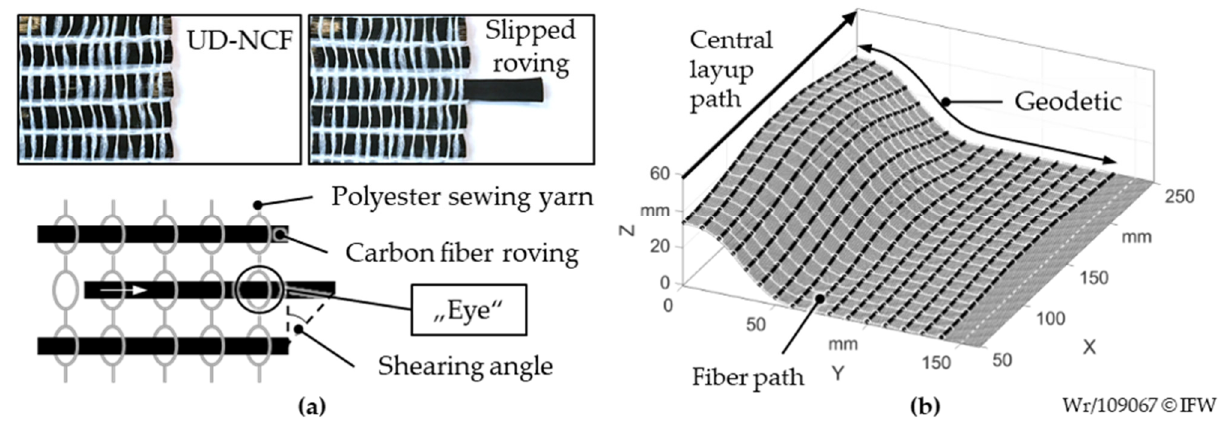
Figure 2. ( a ) New “pin-eye”-approach for kinematic simulation of a loose woven UD-NCF; ( b ) draping simulation in MATLAB.